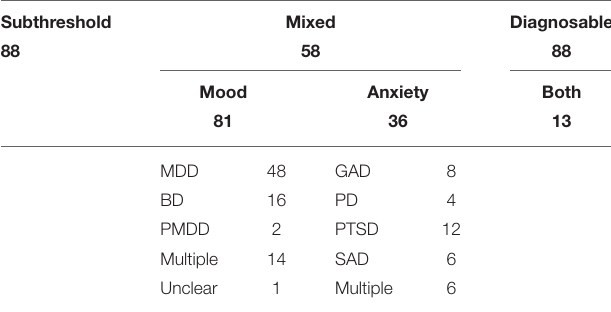
TABLE 1 | Populations studied (Diagnosable